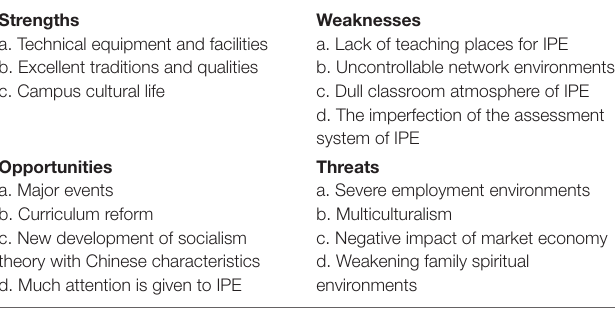
TABLE 8 | The SWOT analysis.